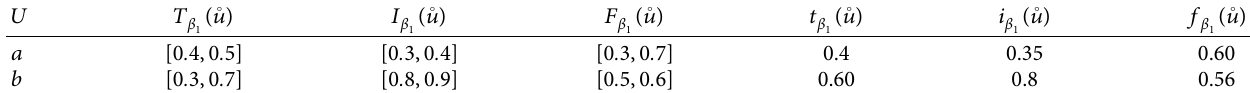
Table 10: Neutrosophic cubic set β